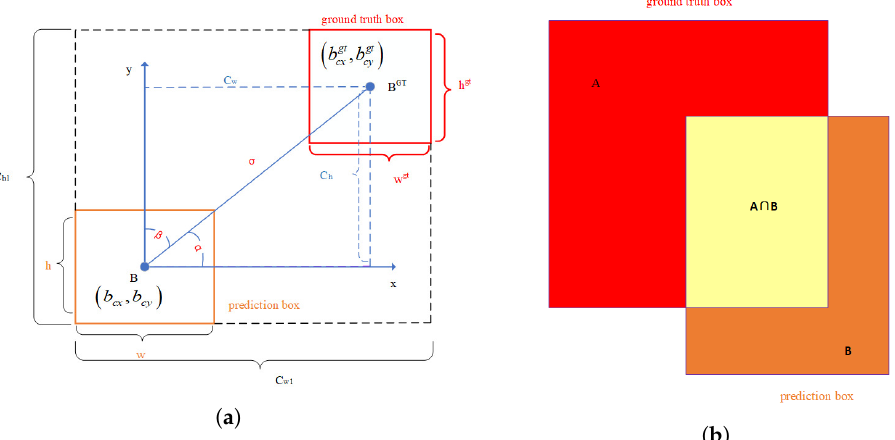
Figure 8. Schematic diagram of the calculation: ( a ) schematic diagram of the calculation of the angle cost; ( b ) schematic diagram of IOU